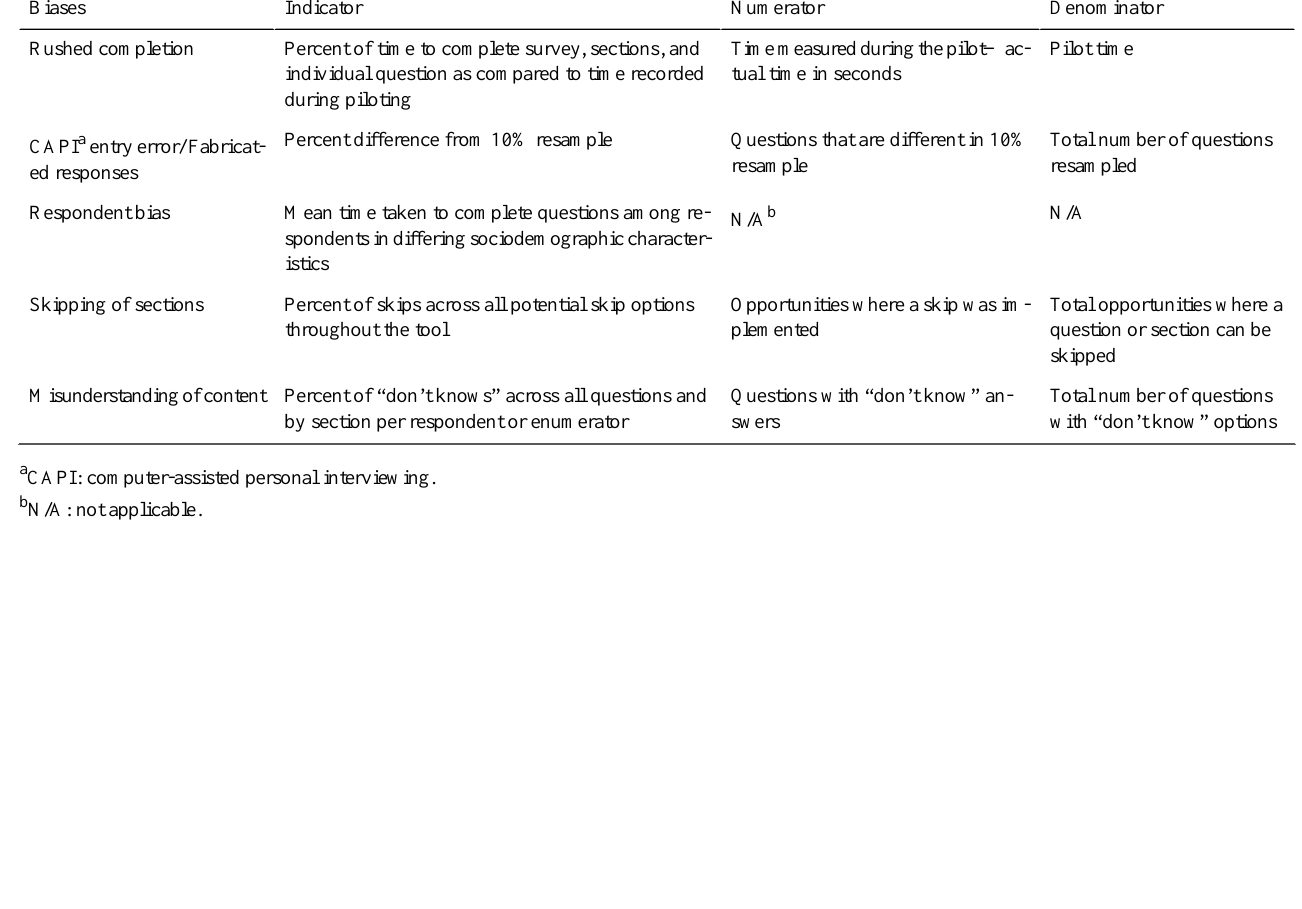
Table 1. Biases in survey completion that can be captured using machine learning. DenominatorNumeratorIndicatorBiases secondsPercent of time to complete survey, sections, and individual question as compared to time recorded